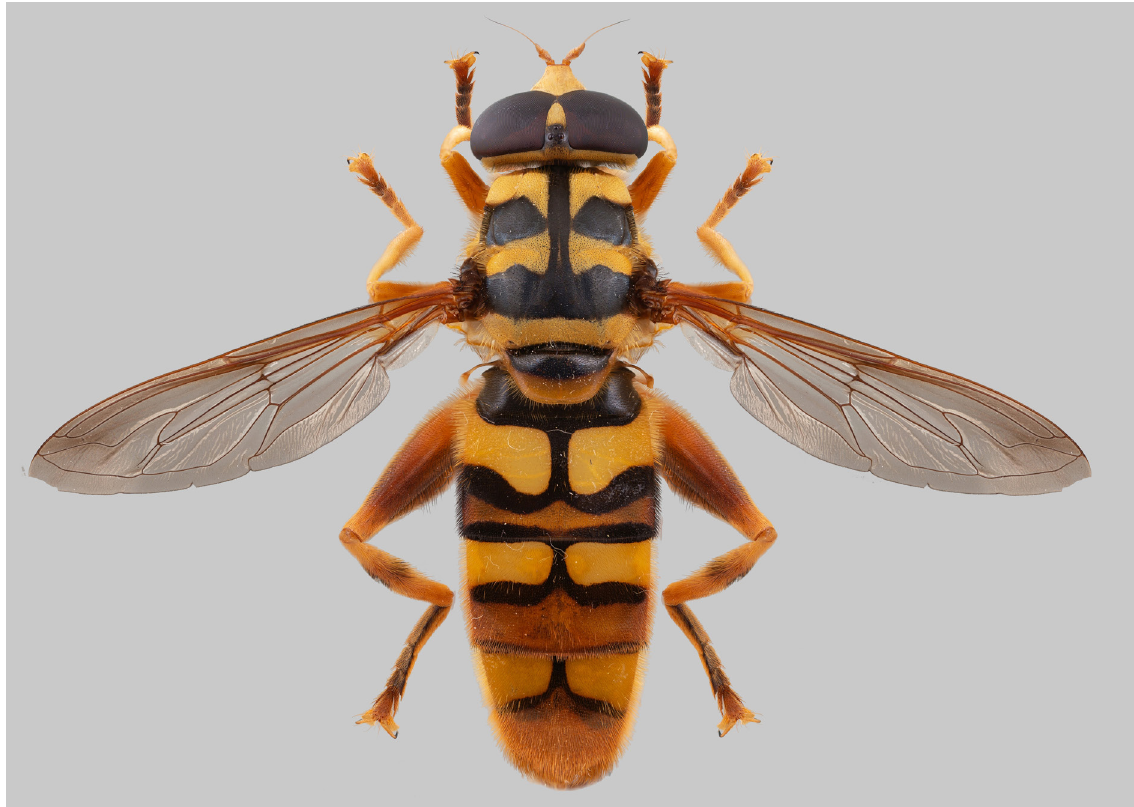
Fig. 6. Milesia virginiensis (Drury, 1773), ♂, (SBH), habitus dorsal. Collected in the USA, South Carolina, 3 September 2018, leg. and coll. S.